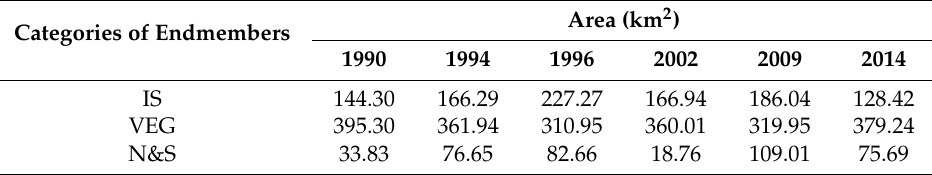
Table 3. Area of the three endmembers in each year.